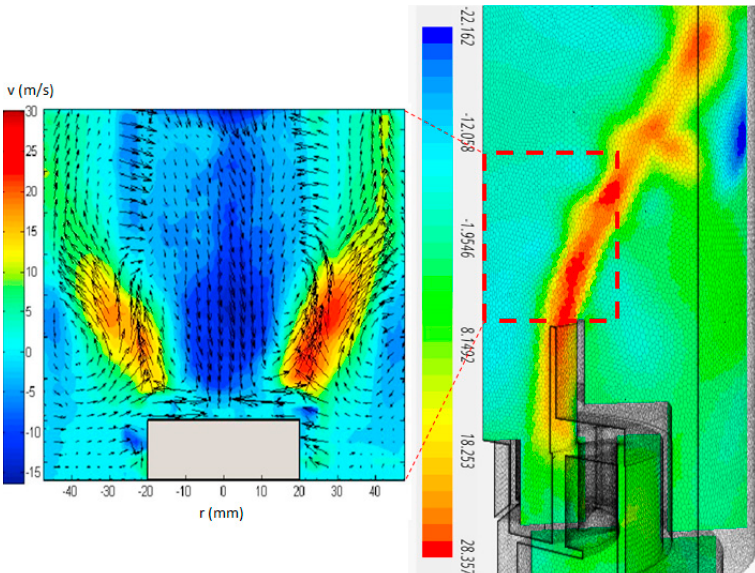
Figure 3. Validation using exhaust emissions profiles. Experiments as in [34,39].